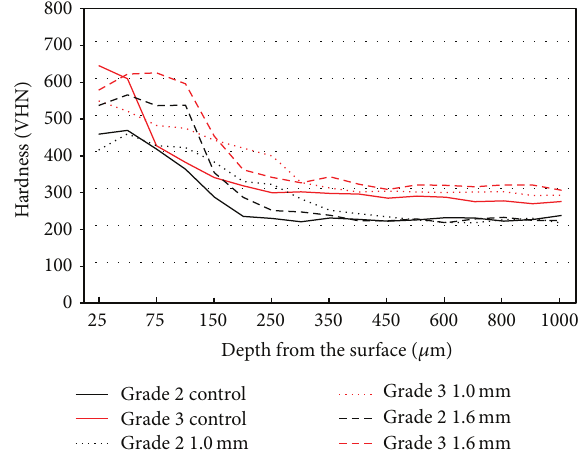
Figure 8: Hardness depth profiles from cast surface for control specimens (grade 2: black solid line, grade 3: red solid line) and specimens laser-treated with two different spot diameters (1.0mm and 1.6mm) at a constant emission current of 200A and a pulse duration